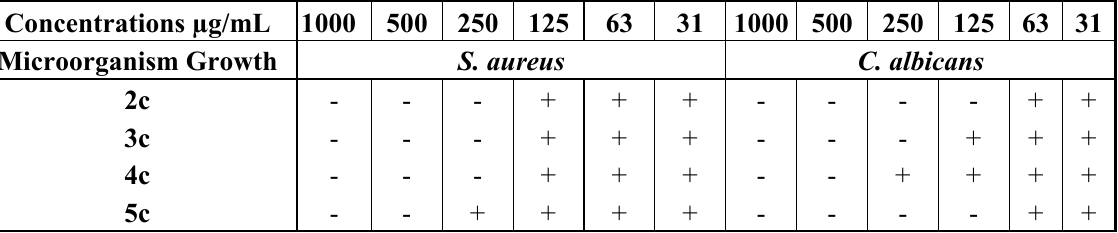
Table 4. Determination of minimum bactericidal concentration (MBC) µg/mL of chloro-derivatives. Concentrations µg/mL Microorganism